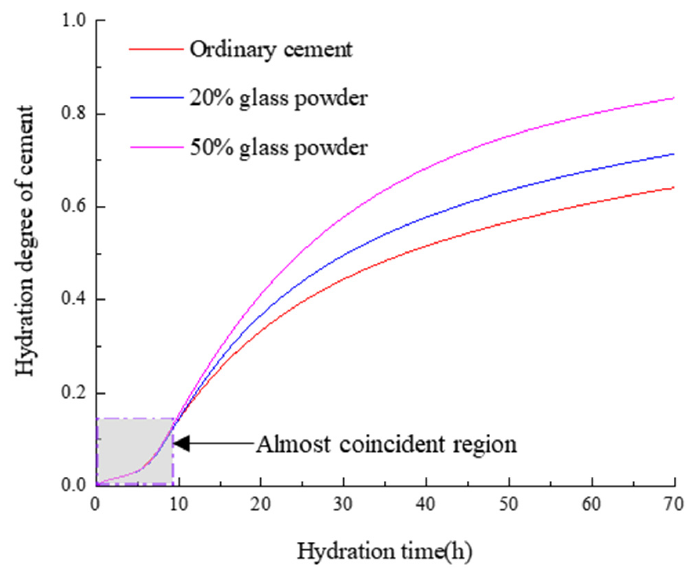
Figure 4. Curve of cement hydration with time.